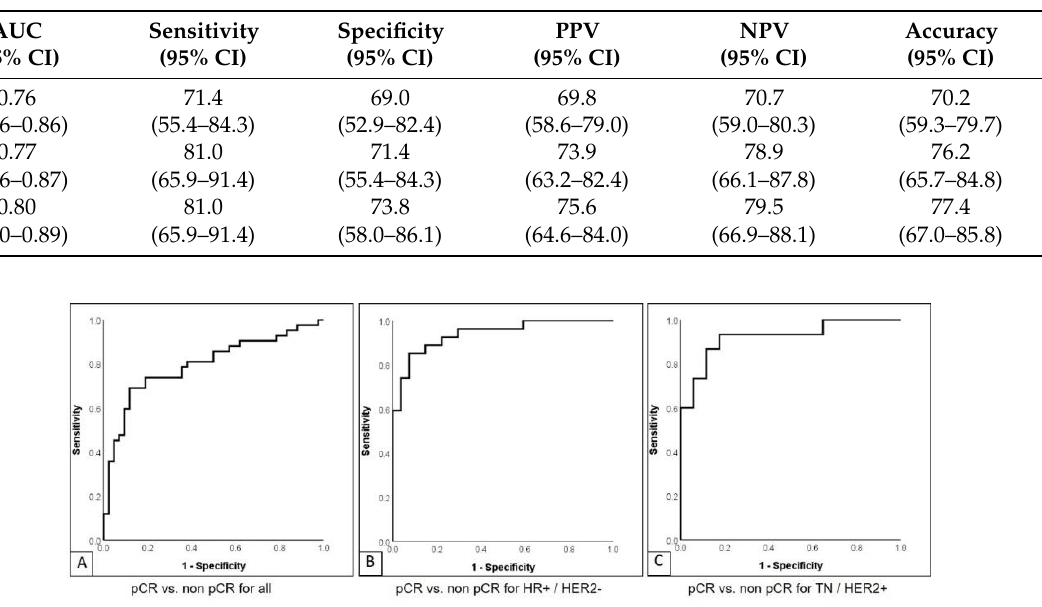
Figure 2. ROC for prediction of pathological response: ROC for prediction of pathological response based on the combination of all MR and PET data in ( A ) entire cohort, ( B ) in the subgroup of HR+/HER2 − patients, and ( C ) in the subgroup of TN/HER2+ patients.